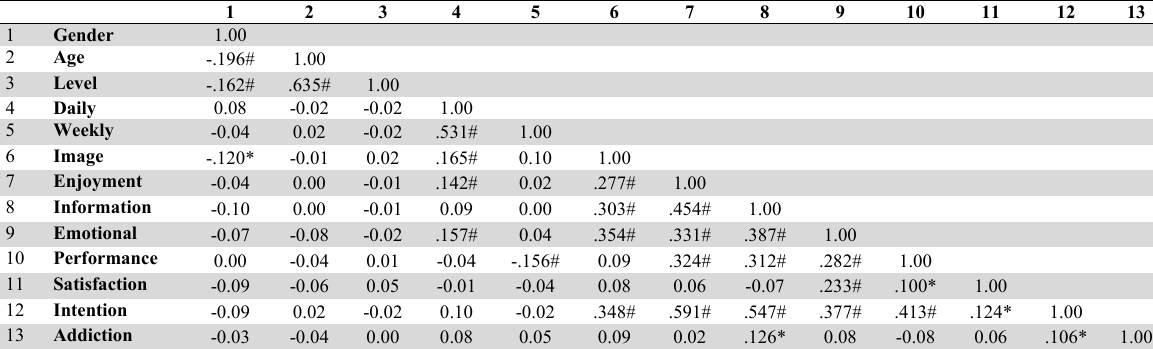
Person correlations